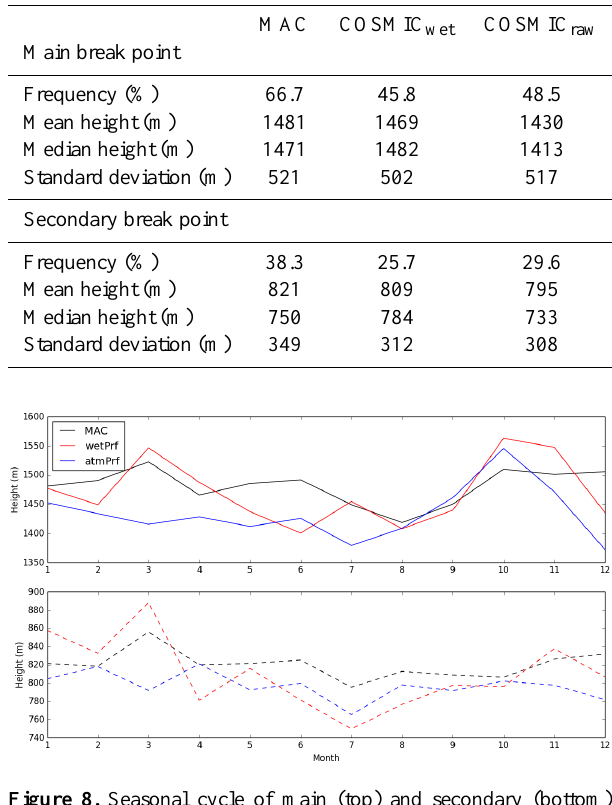
Figure 8. Seasonal cycle of main (top) and secondary (bottom) break points for MAC (black), COSMIC wet (red), and COSMIC raw